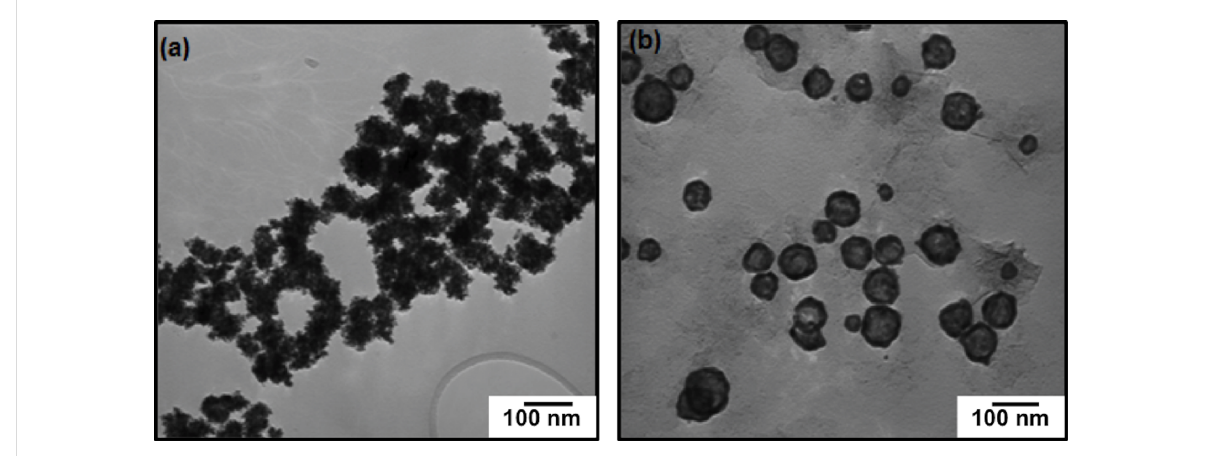
Figure 6: TEM images of Au@Co magnetic nanoparticles prepared (a) in the absence of PVP and (b) in the absence of a magnetic stirrer.